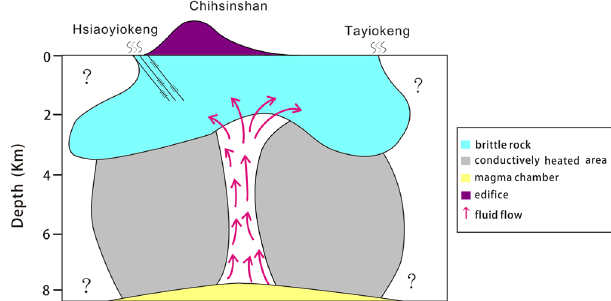
Fig. 11. Possible configuration of the volcano-hydrothermal sys- tem beneath TVG suggested by Konstantinou et al. (2007). Main elements of this model are the magma body at depths 7–8km and the highly cracked, fluid-saturated rock where HF seismicity occurs. Hsiaoyiokeng is an area adjacent to the Chihsinshan edifice which also exhibits strong fumarole activity fed by a system of